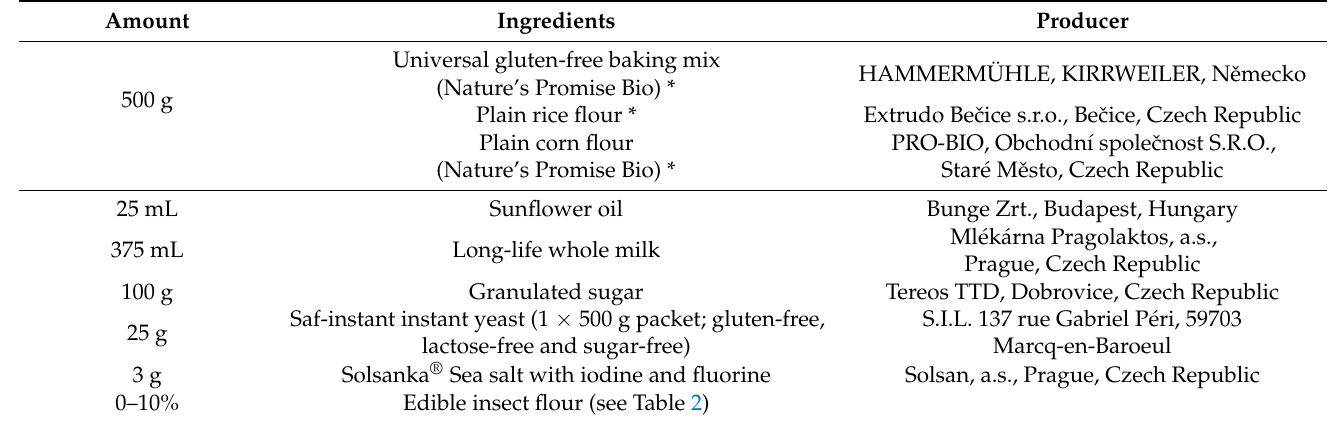
Table 1. Content of ingredients used to monitor the fermentation of a basic dough.